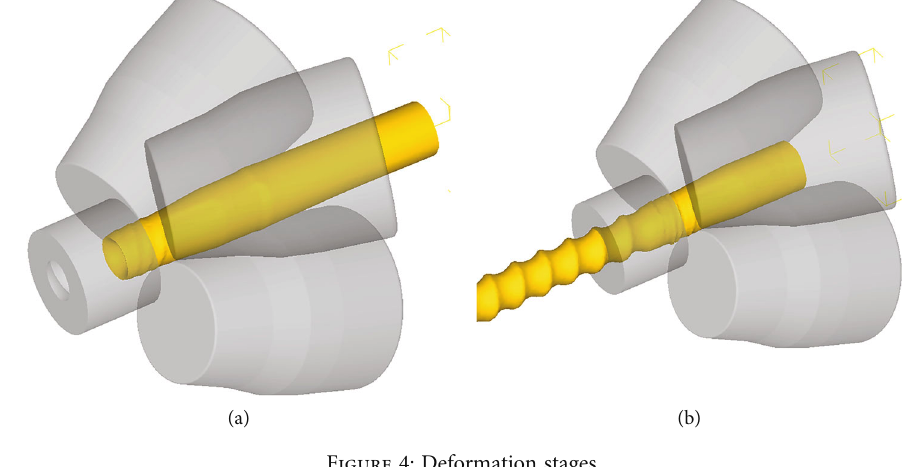
Figure 4: Deformation stages.